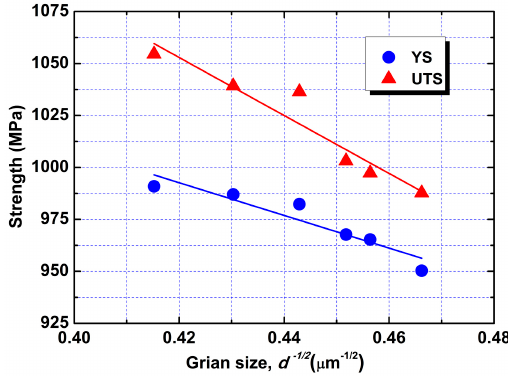
Figure 8. Variation of tensile properties of IA states as a function of drawing deformation. Metals 2017 , 7 , 131